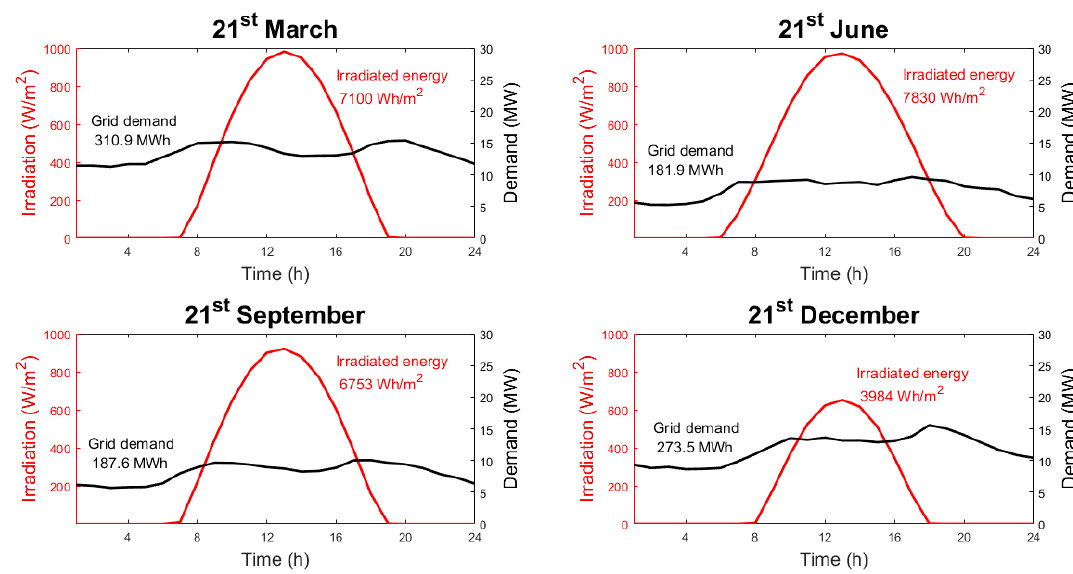
Figure 2. ISCC boundary conditions; grid demand curves (in black) and solar direct normal irradiation (in red) for the plant location.